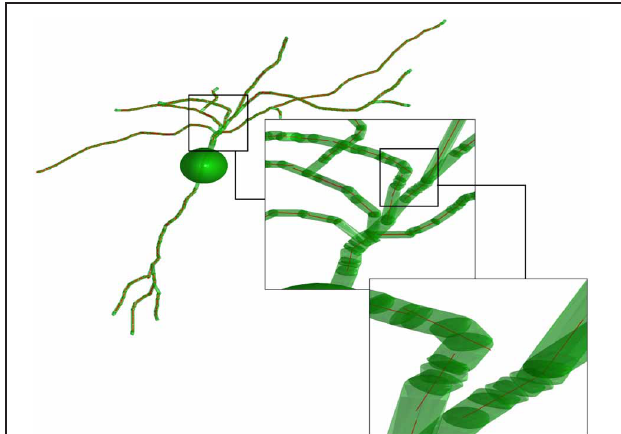
FIGURE 2 | Illustration of the representation of the neurons. The transparent green cylinders represent the axons and dendrites, while the red lines represent the average line segments. A line segment length of 5 μ m has been used. The image is based on a neocortex neuron from a 44 days old rat [entry P44_DEV203 of the NeuroMorpho.org database (Furtak et al.,